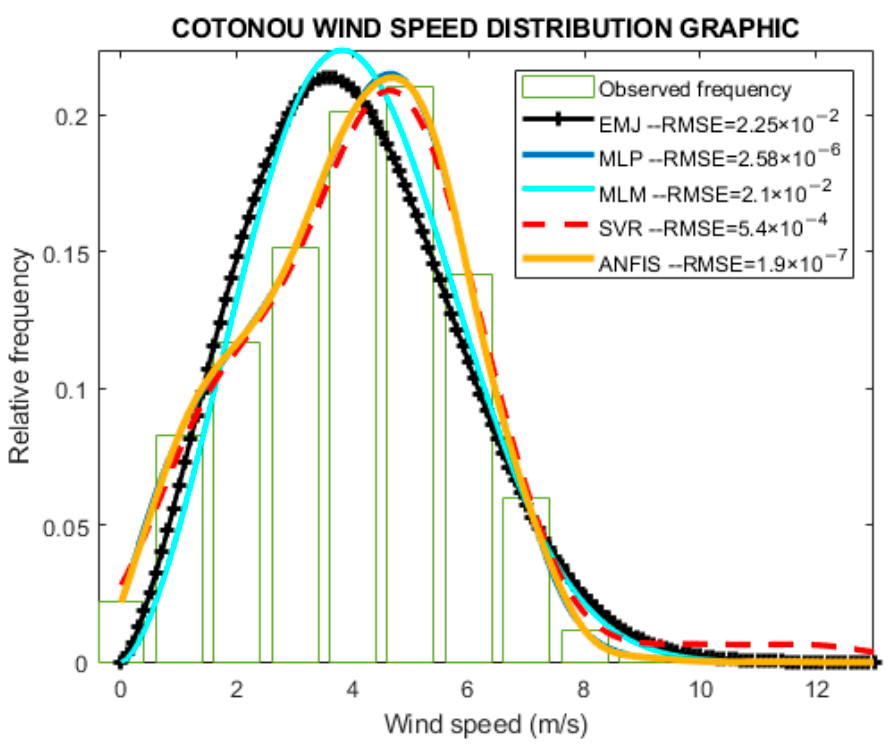
Figure 10. Wind speed distribution function for the site of Cotonou. Table 10. Method